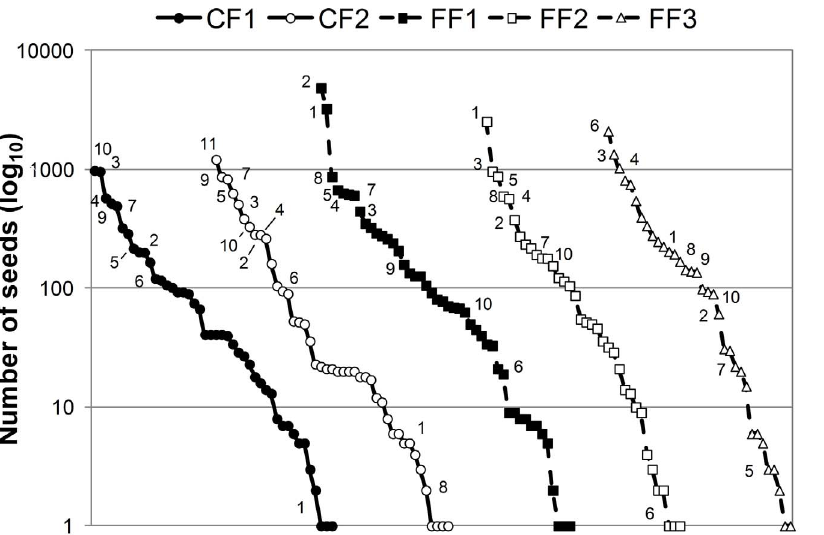
Figure 5. Relative abundance of seeds deposited by spider monkeys in latrines located in each study site. The identity of dominant species within each site is indicated: 1. Sabal mexicana ; 2. Dialium guianense ; 3. Castilla elastica ; 4. Spondias radlkoferi ; 5. Trophis mexicana ; 6. Rourea glabra ; 7. Paullinia costata ; 8. Bactris mexicana ; 9. Trichostigma octandrum ; 10. Ampelocera hottlei ; 11. Mendoncia retusa .